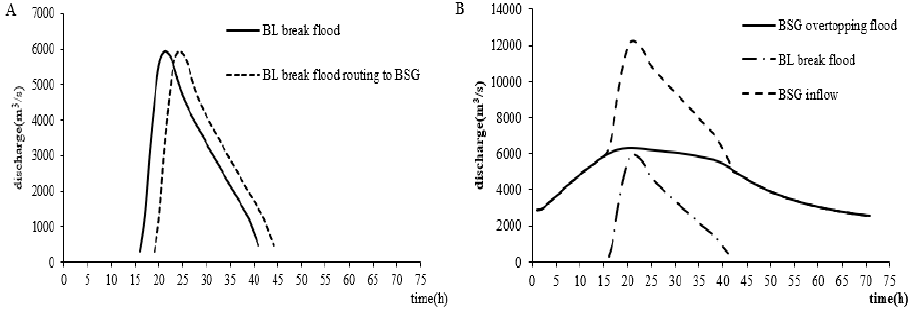
Figure 9. ( A ) The BL break flood routing to SJK dam site. ( B ) The BL break flood encounters BSG overtopping flood.